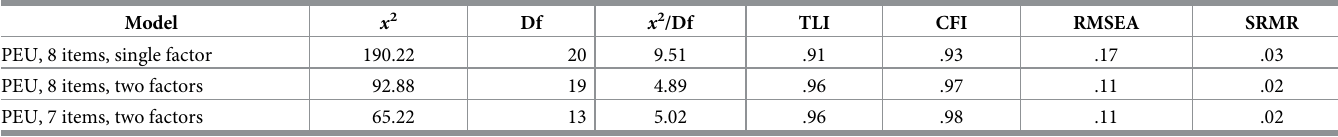
Table 3. Fit statistics for competing models for perceived evidence use (Study